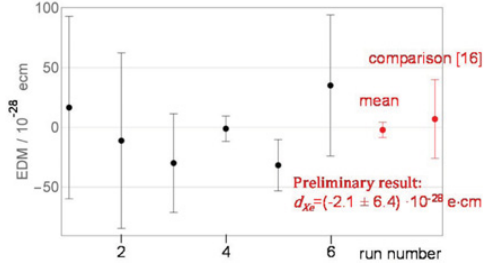
Figure 6. EDM values of different runs.